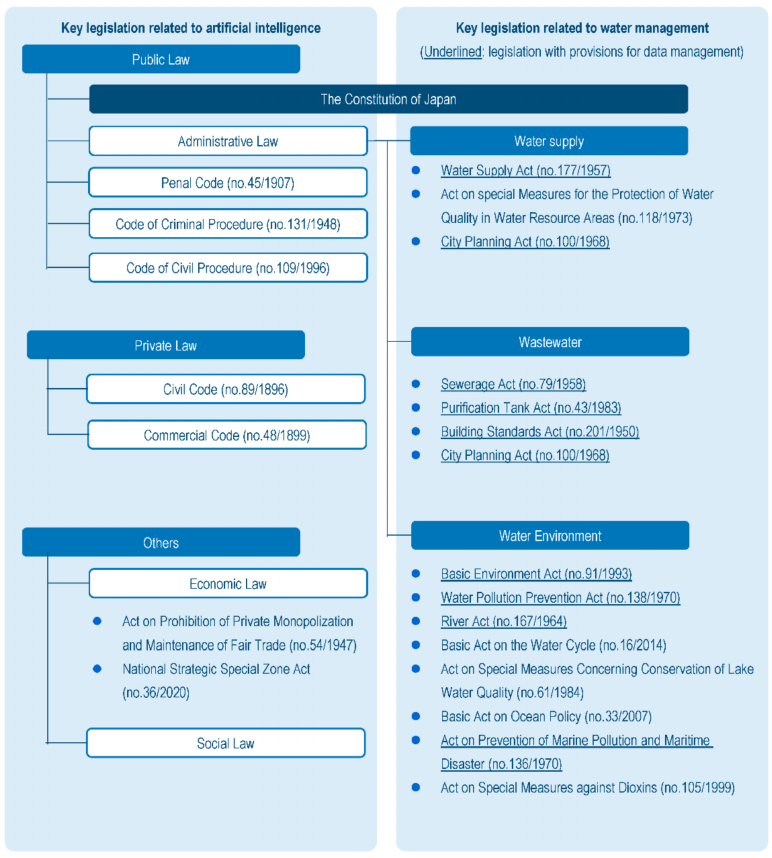
Figure 1. Overview of key legislation pertaining to artificial intelligence and water in Japan (compiled by authors based on the Ministry of Internal Affairs and Communications